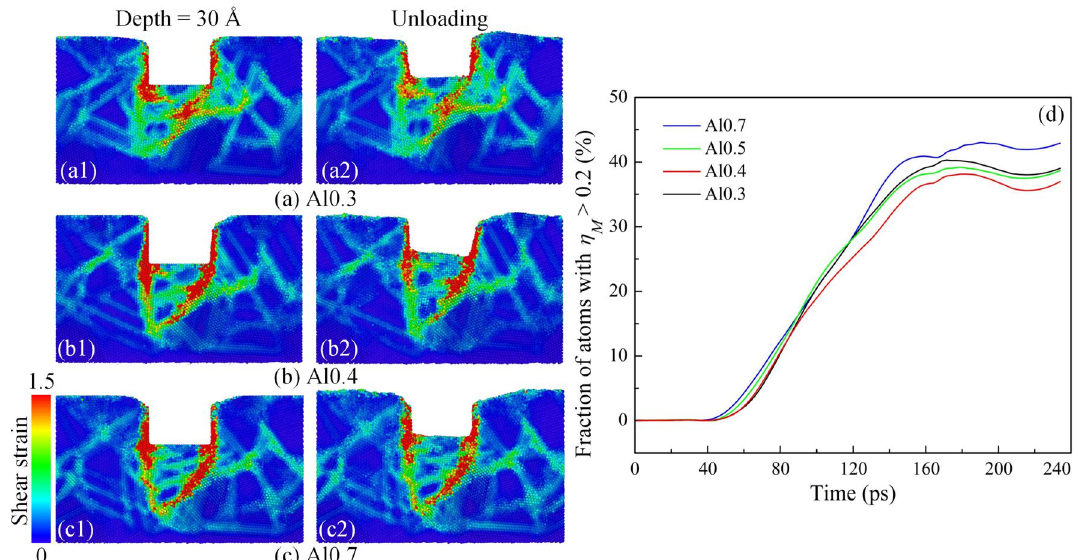
Figure 9. The cross-section of atomic shear strain distributions for the polycrystalline structure of the Al x CoCrFeNi HEA at an imprinting depth of 30 Å and the unloading stage with different alloy compositions: Al0.3 ( a ); Al0.4 ( b ); and Al0.7 ( c ). The fraction of atoms with atomic shear strain value η M greater than 0.2 ( d